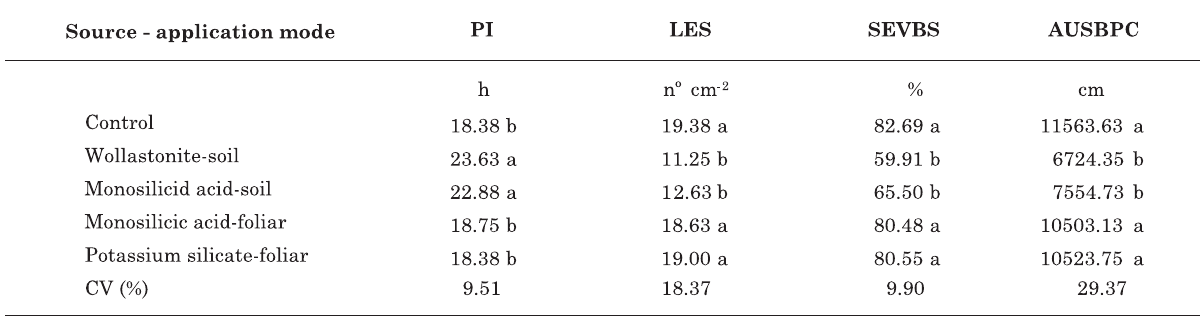
Means followed by the same letter within a column are not significantly different at the 0.05 level by the Tukey Test.